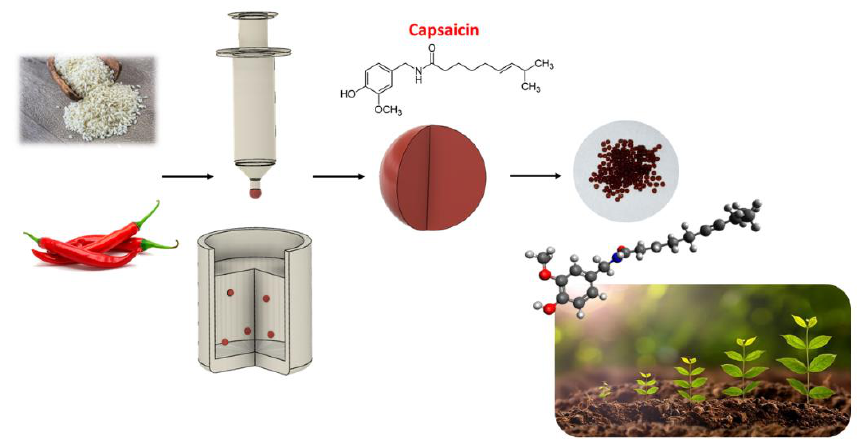
Figure 1. Schematization of gelation process of B-PE.